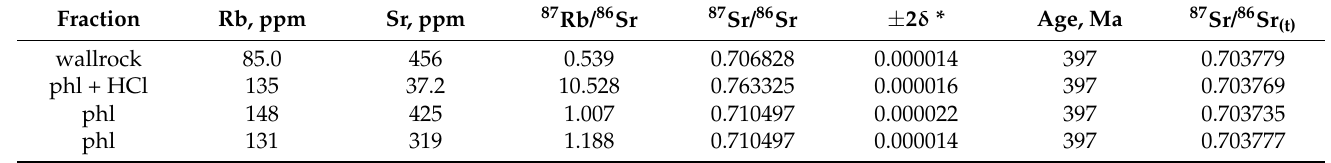
Table 2. Rb–Sr isotopic data on phlogopite from the kimberlite of the sill 697.